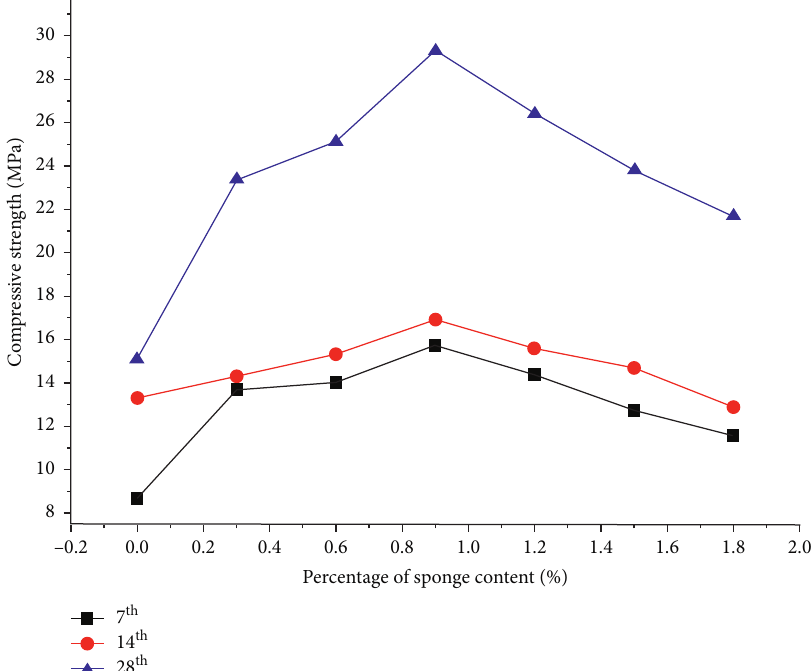
Figure 3: Compressive strength of concrete specimens with different sponge contents on the 7 th , 14 th , and 28 th